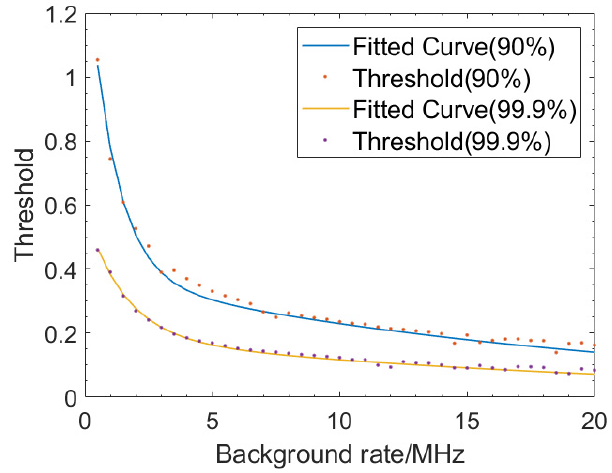
Figure 8. The cumulative probability distribution to determine the threshold position (background photon counts rate = 5MHz).